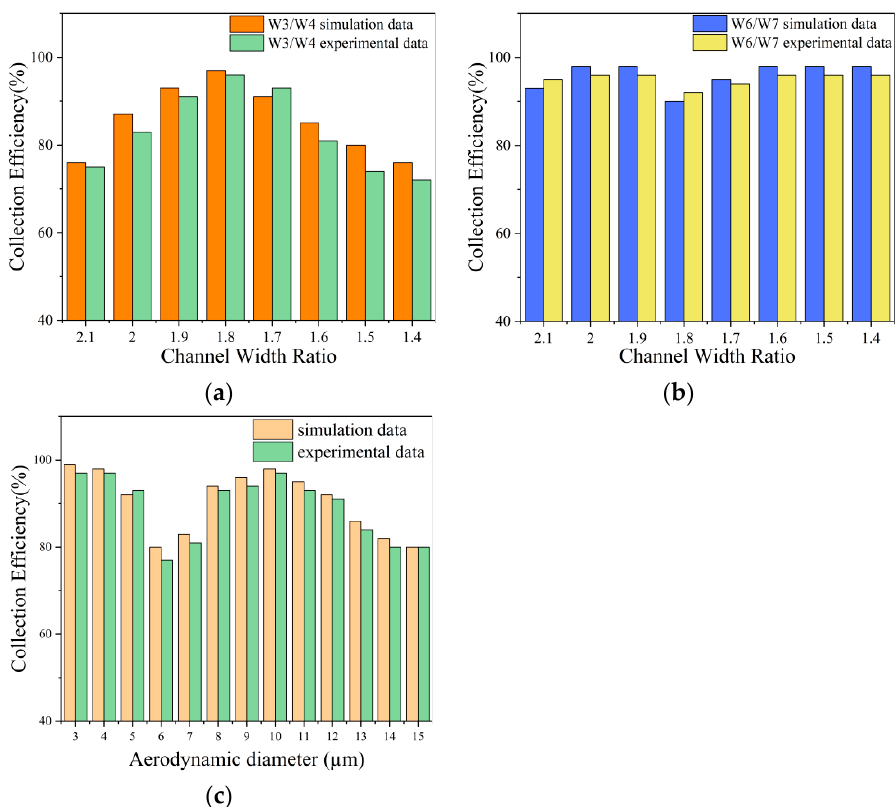
Figure 7. Comparison of chip test and simulation results. ( a ) Simulation and experimental results for W3/W4, ( b ) Simulation and experimental results for W6/W7, ( c ) is the collection effect of the microfluidic chip on the atomized particles of different sizes.